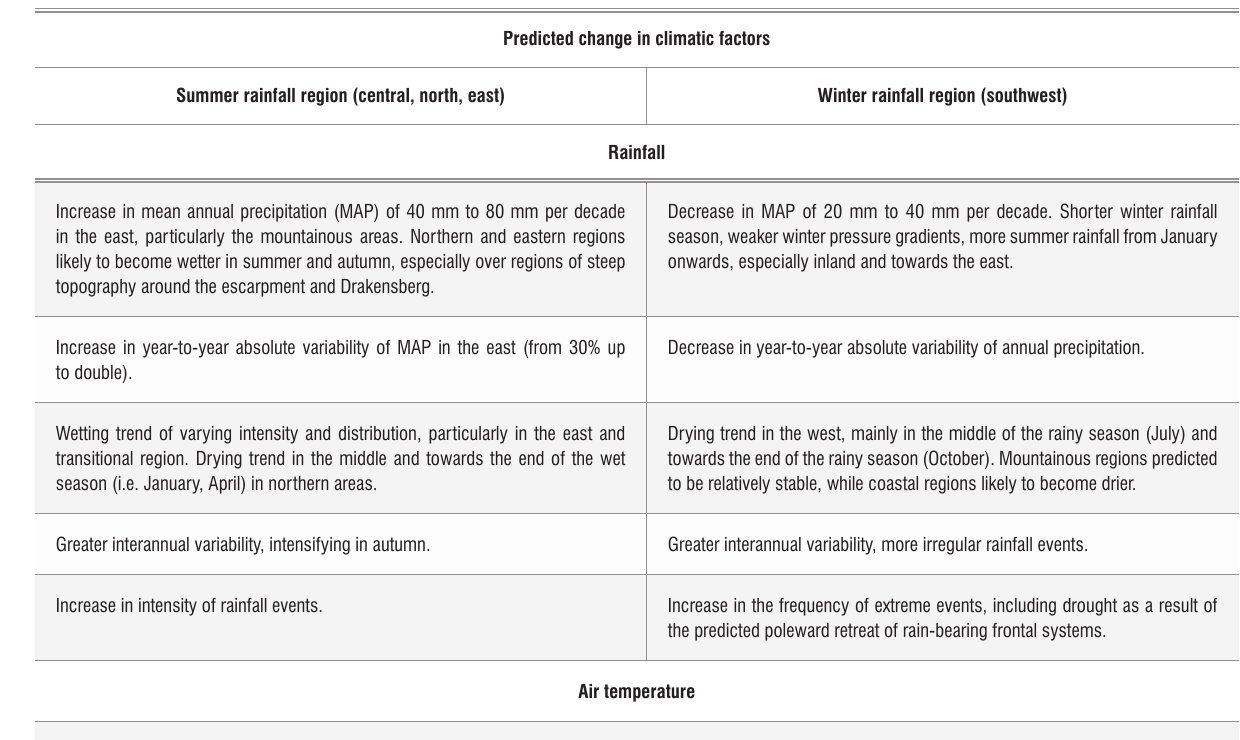
Table 1: Responses of rainfall and air temperature for the summer and winter rainfall regions of South Africa as predicted by global climate change models 5,8,9,119